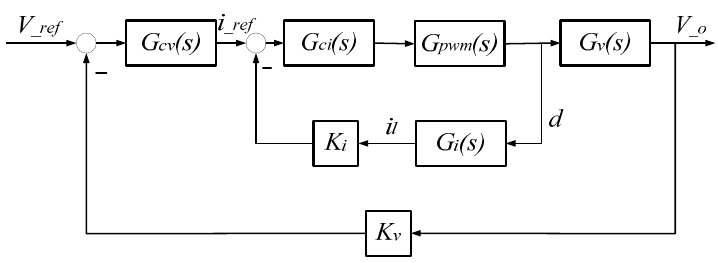
Figure 8. Transfer function diagram the power storage system.